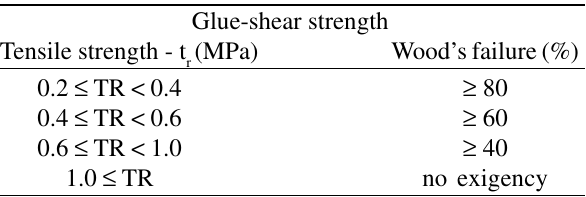
Table 5. Requirements of the European Standard for the plywood’s glue-shear strength.